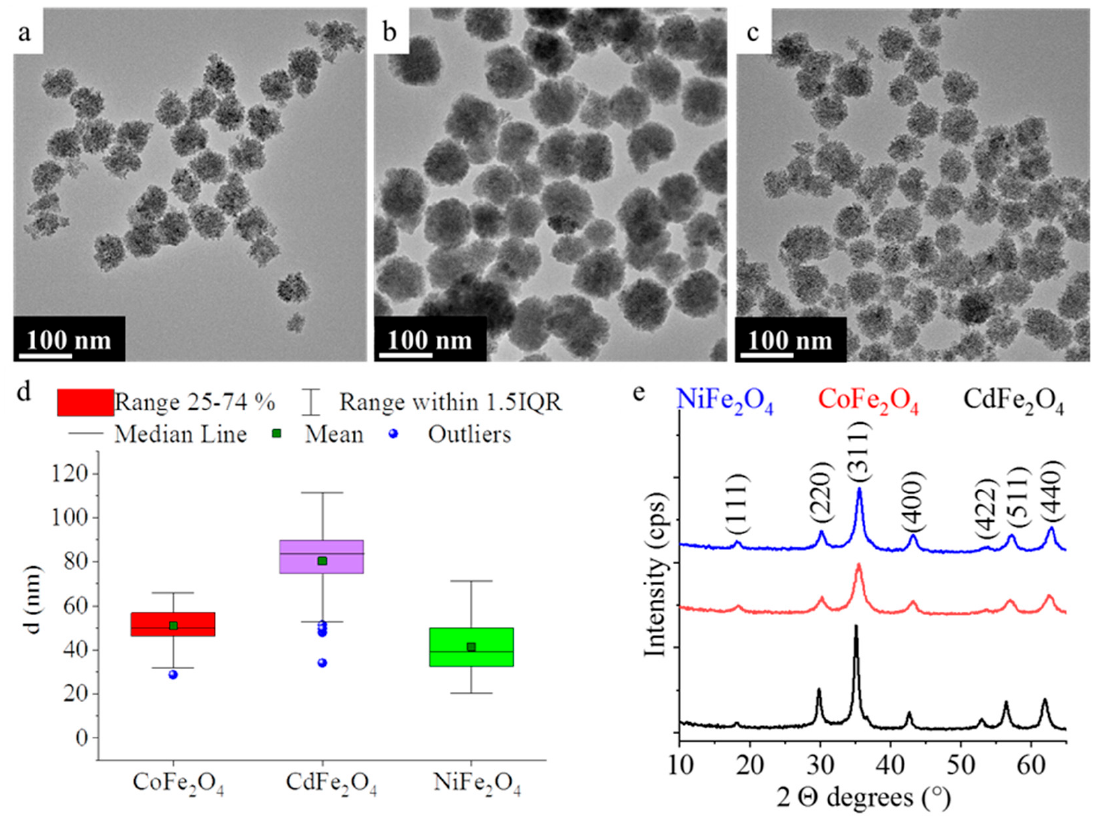
Figure 1. HRTEM pictures of the CoFe 2 O 4 -NH 2 ( a ), CdFe 2 O 4 -NH 2 ( b ) and NiFe 2 O 4 -NH 2 ( c ). Box plot diagrams for the particle size analysis ( d ) and the XRD pattern of the ferrites ( e ). In contrast, the average particle sizes of the aggregate ferrite spheres, namely CoFe 2 O 4 -